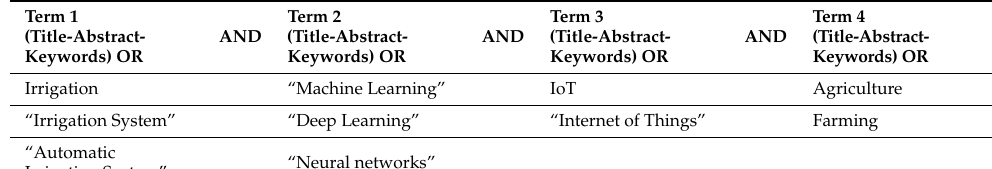
Table 1. The first search equation.